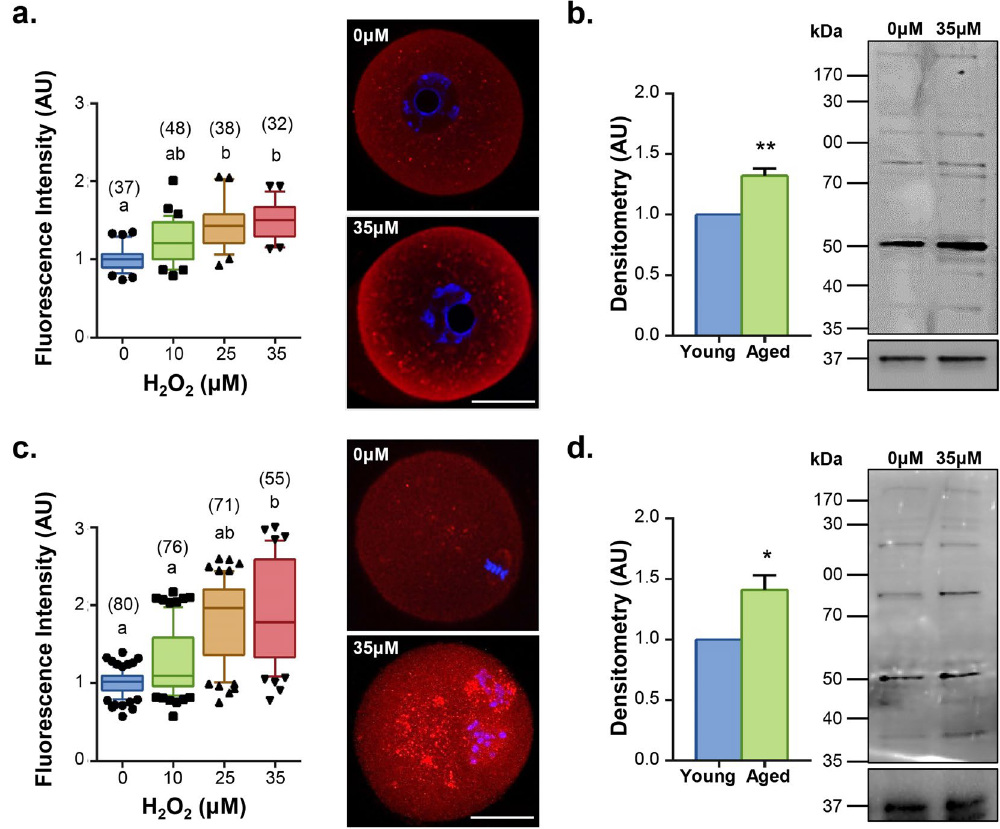
Figure 2. OS induces the generation of 4-HNE. Immunocytochemistry and immunoblotting were used to determine whether an increase in 4-HNE modifications could be elicited by H 2 O 2 treatment. For immunocytochemical analysis, GV oocytes were treated with 10, 25 or 35 μ M H 2 O 2 for 1 h and immediately fixed or underwent IVM for subsequent fixation at MII. Both ( a ) GV ( p ≤ 0.0440) and ( c ) MII oocytes ( p ≤ 0.0280) showed a dose-dependent increase in 4-HNE expression (red). Nuclei were counterstained with Hoechst (blue). Scale bar = 20 μ m. Box and whisker plots shows mean as the centreline, box as the 25–75th percentiles and whiskers as the 10–90th percentiles. Immunocytochemistry was performed with three biological replicates with each replicate containing between 10–30 oocytes pooled from a minimum of three animals. ( b ) An increase in the adduction profile of 4-HNE following H 2 O 2 treatment was also confirmed in both GV and ( d ) MII oocytes via 4-HNE immunoblotting, again indicating an increase in 4-HNE modification at 35 μ M H 2 O 2 . Pixel intensity was calculated across entire lanes for the purpose of densitometry analysis. Immunoblots were stripped and re-probed with GAPDH as a loading control. Error bars represent SEM. Statistical analyses were performed using Student’s t-test, * p ≤ 0.05 and ** p ≤ 0.01. Immunoblots were performed in biological and technical triplicate using 100 oocytes per lane pooled from a minimum of three